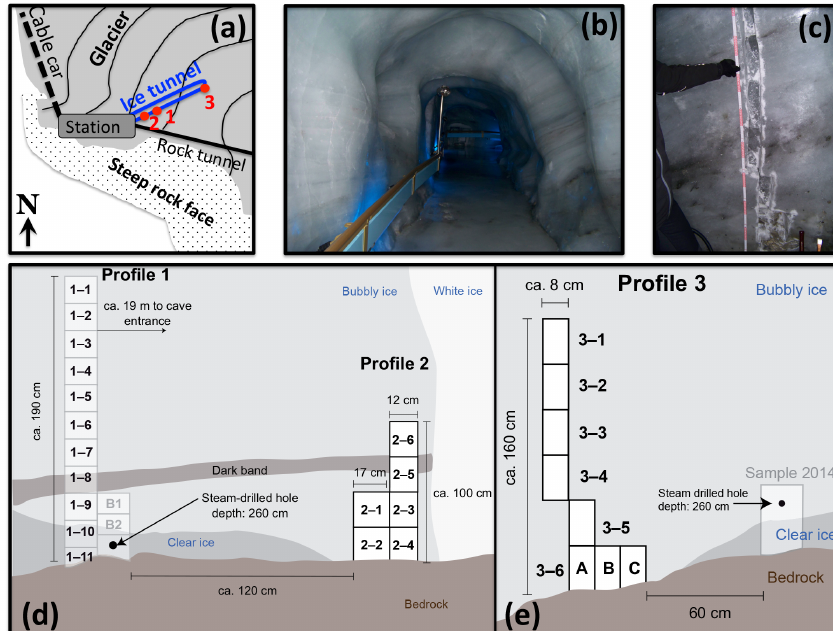
Figure 2. Overview on ice sampling at the Chli Titlis glacier. Panel (a) shows a schematic diagram with ice sampling locations within the ice tunnel. Distinct near-horizontal layering is visible within the tunnel (b) . A total of three ice block profiles were cut by chainsaw down to bedrock (c) . Panels (d, e) present schematic details on the ice block sampling. Note that two additional blocks (2-7 and 2-8) were cut in parallel behind block